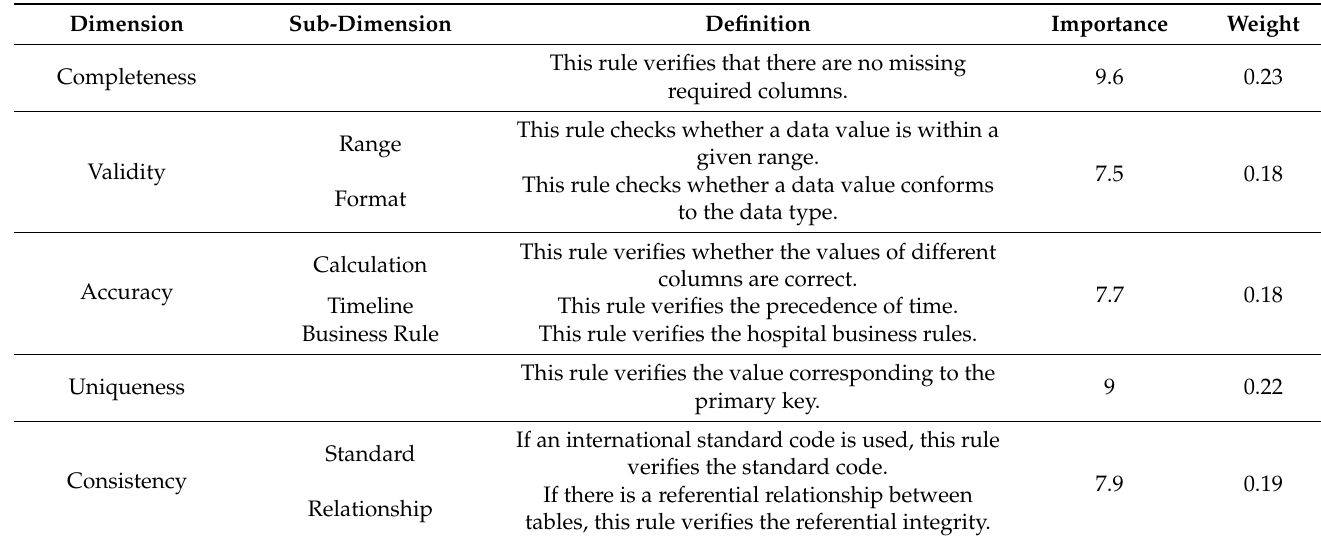
Table 1. DQ4HEALTH dimensions of specialist group